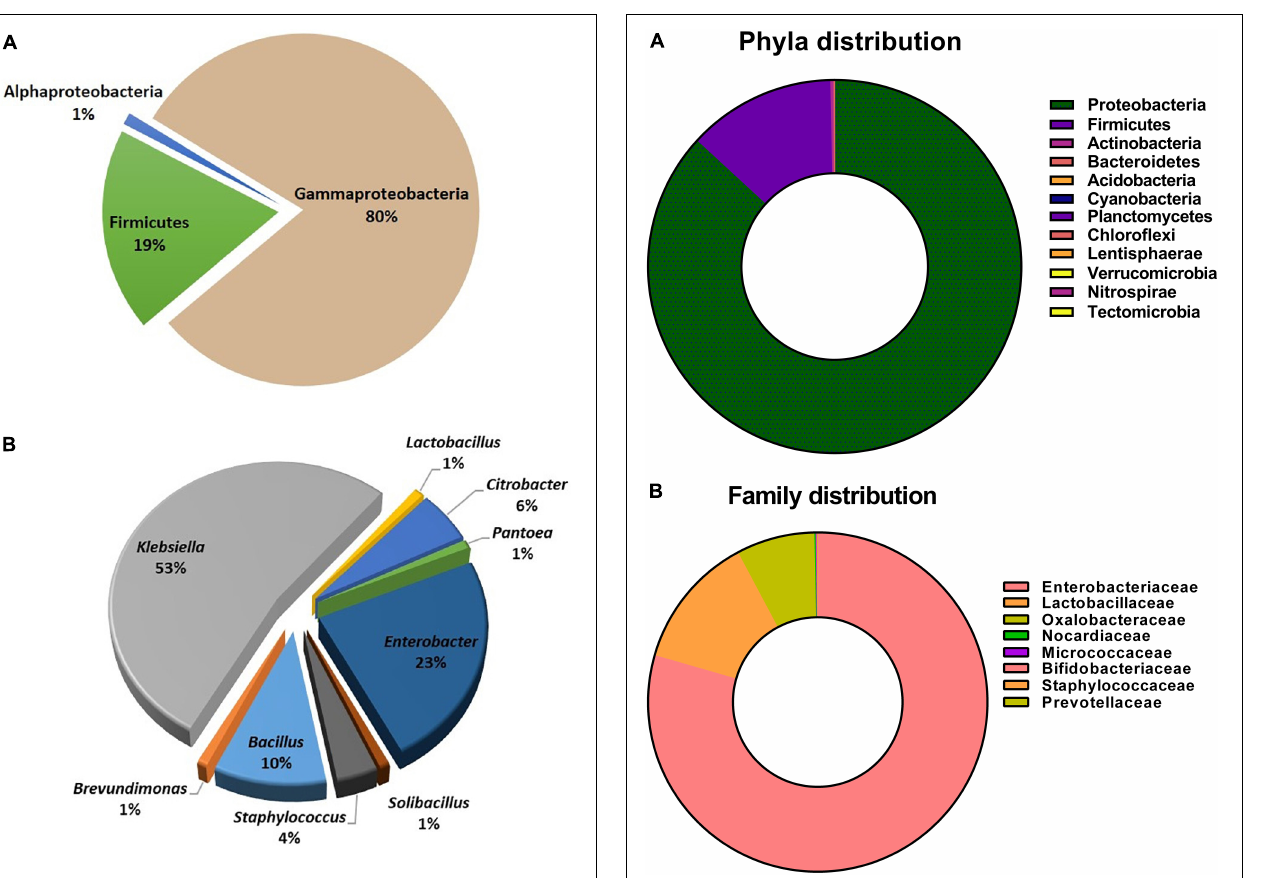
FIGURE 2 | Classification of cultured gut bacterial flora of Apis florea . The gut bacterial isolates were classified based on MALDI-TOF-MS and 16S rRNA gene sequencing data. (A) Bacterial phyla and (B) bacterial genera.